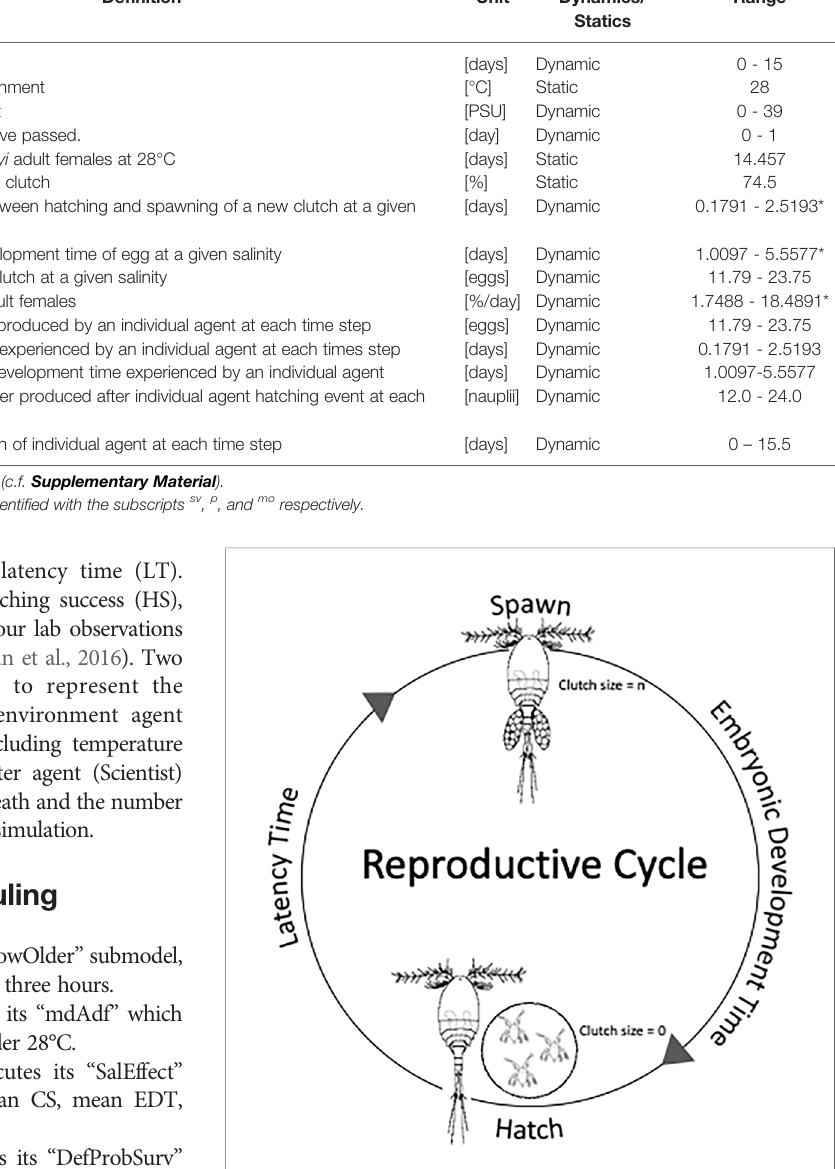
TABLE 2 | Attributes of non-located agents facilitating the computation of the reproductive cycle of the Adult female copepod Apocyclop royi (ParamX) , the environment ( Envi ), and the one used to extract and save the output data ( Scientist ). Agent